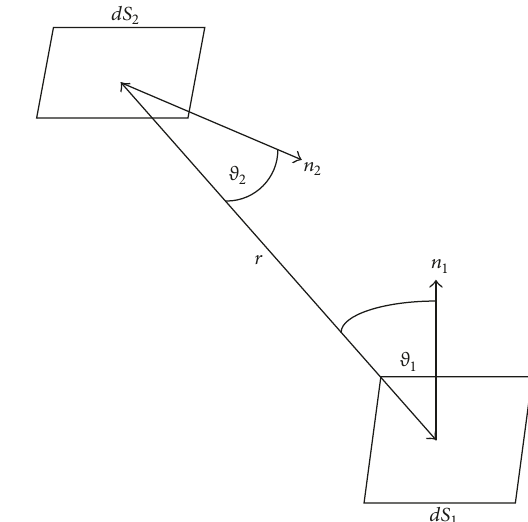
Figure 6: Diagram of surfaces in radiation heat